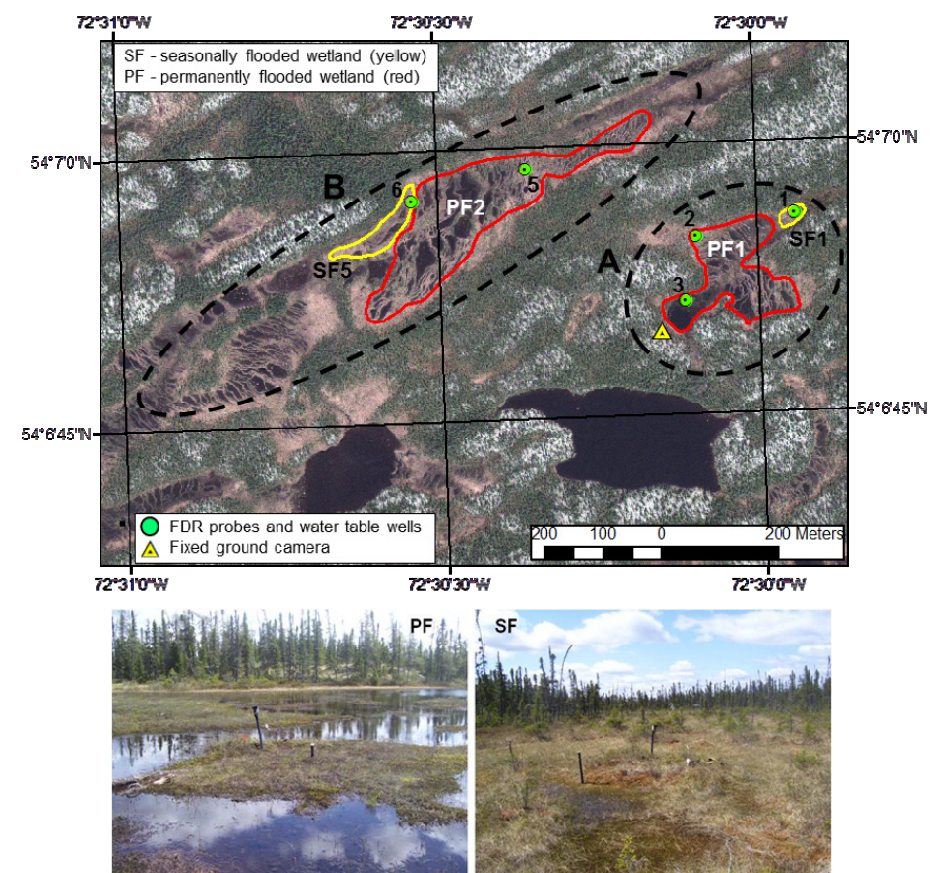
Figure 2. The distribution of studied “La Forge” peatlands (A and B), as well as the ground measurement location (background: GeoEye Satellite image). Below, ground photos showing a landscape view of permanently flooded (PF) and seasonally flooded peatlands (SF). FDR, frequency domain